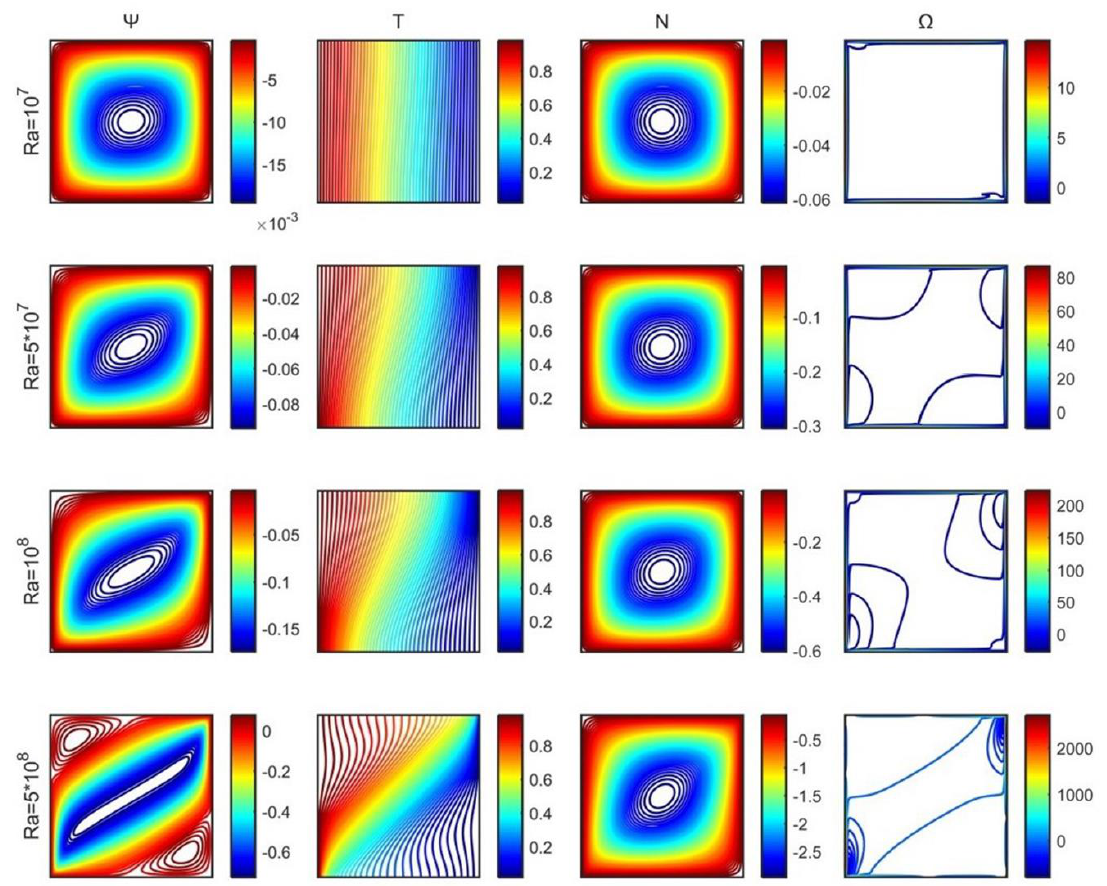
Figure 8. Stream function ( Ψ ), temperature ( θ ), microrotation ( N ), and vorticity ( Ω ) contours for a Figure 8. Stream function ( 𝛹 ), temperature ( 𝜃 ), microrotation ( 𝑁 ), and vorticity ( 𝛺 ) contours for a range of Rayleigh range of Rayleigh numbers